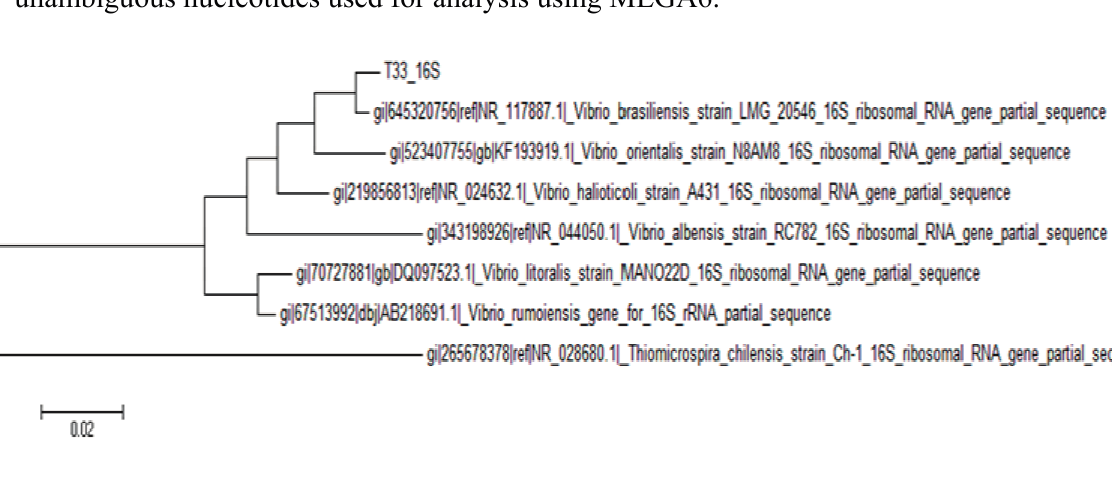
Figure 2. Phylogenetics analysis of strain T33. The tree is drawn to scale, and branch lengths represents number of base substitutions per site. There were a total of 1244 unambiguous nucleotides used for analysis using